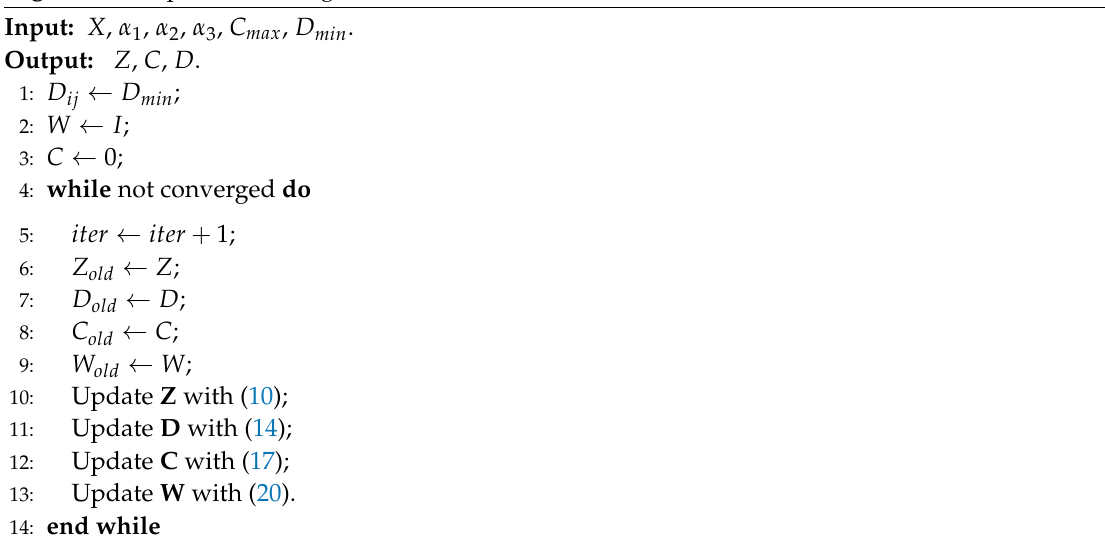
Algorithm 1 Optimization algorithm for